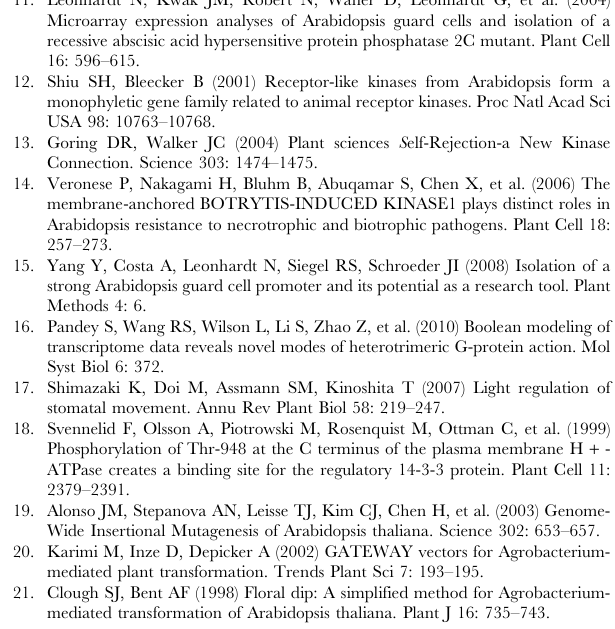
Figure S2 pAPK1B: GUSGFP is predominantly ex- pressed in mature guard cells. Fluorescence of 14 day old